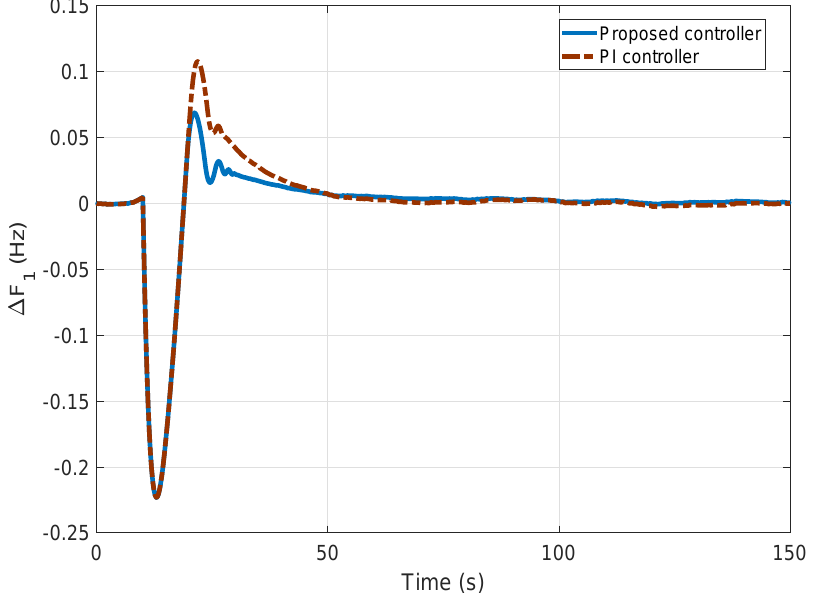
Figure 16. Frequency deviation in area 1 with proposed controller and PI controller.